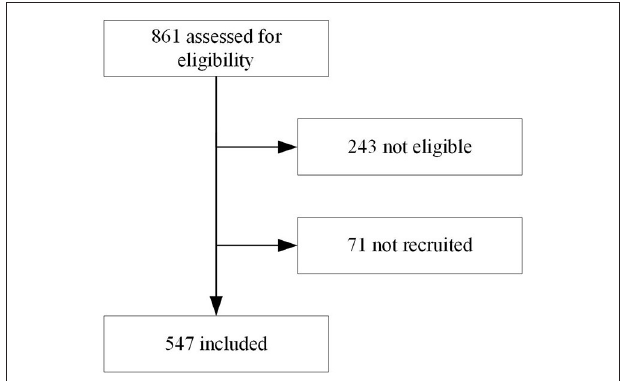
FIGURE 1 | Flowchart of